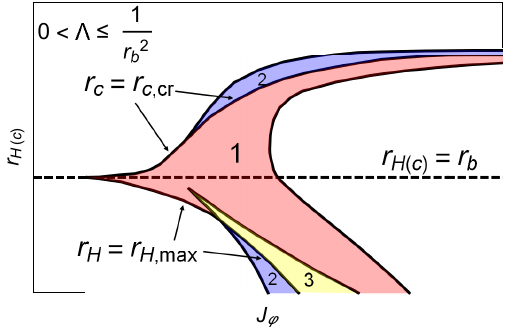
plane of Euclidean H ( c ) . (A example of parameters that r 2 √ √ b Λ , M ) = (5 G, 0 . 0012 /G, 0 . 1 / G ) b ,